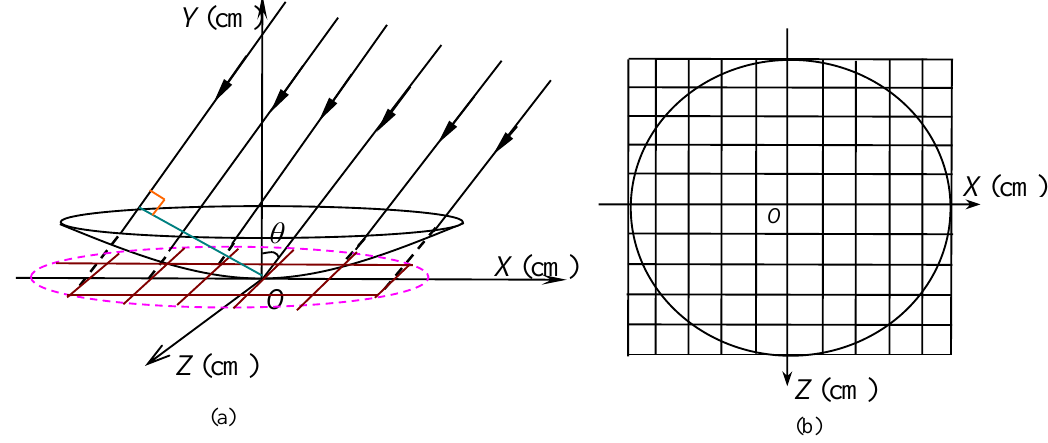
Figure 5. The diagrammatic sketch of the aperture of incident solar beam. ( a ) side view of the incident ray with a radius of 10 cm; ( b ) top view of the incident ray with a side length of 20 cm. 4.2. Seeking Parameters of the Optimal Aspheric Surface Whose Vertex Is at the Origin of the X′Y′Z′ Coordinate System